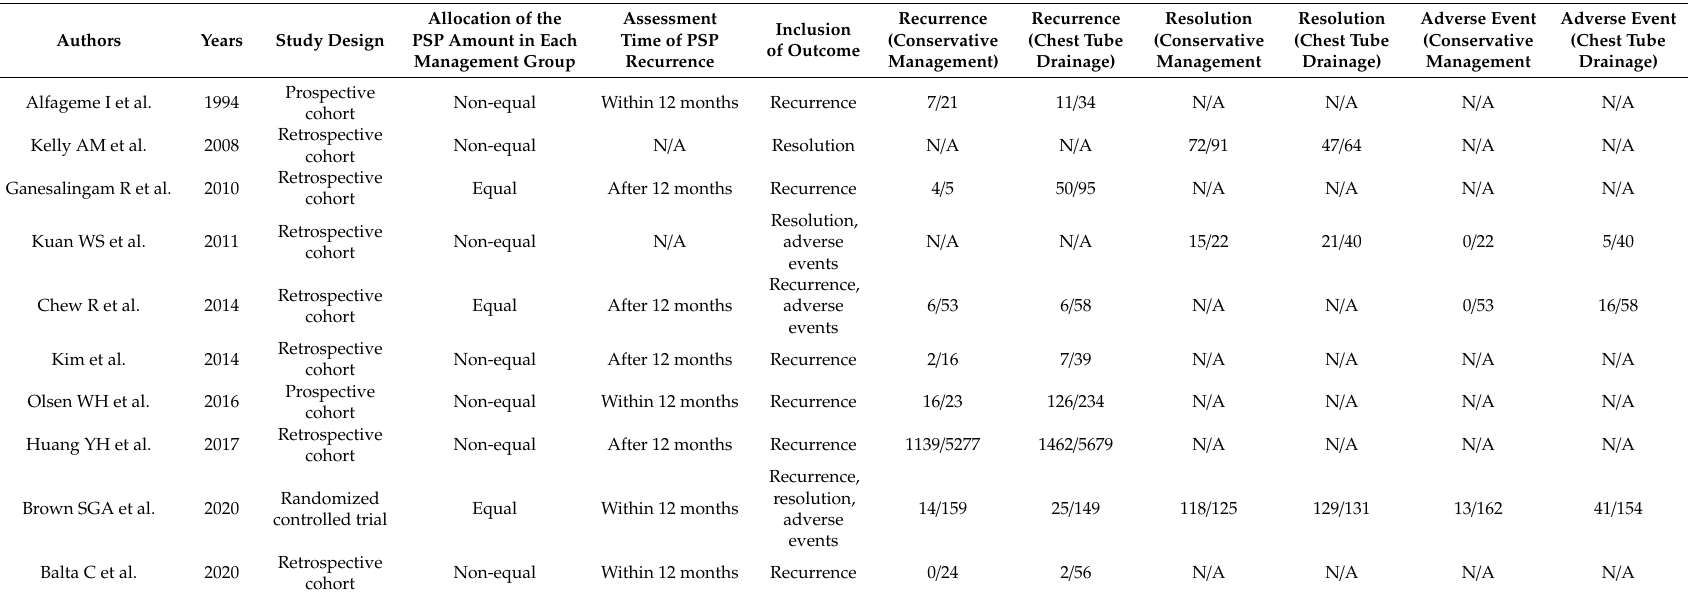
Table 1. Characteristics of studies included in the